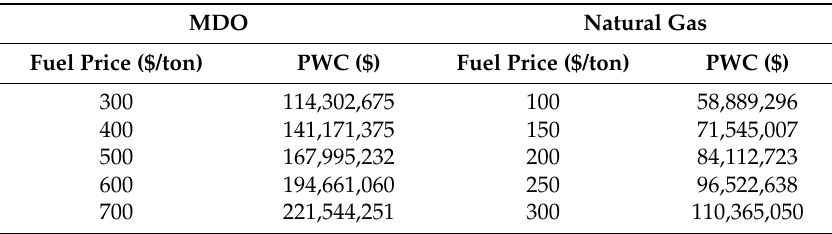
Table 16. Optimal PWC for varying fuel price.